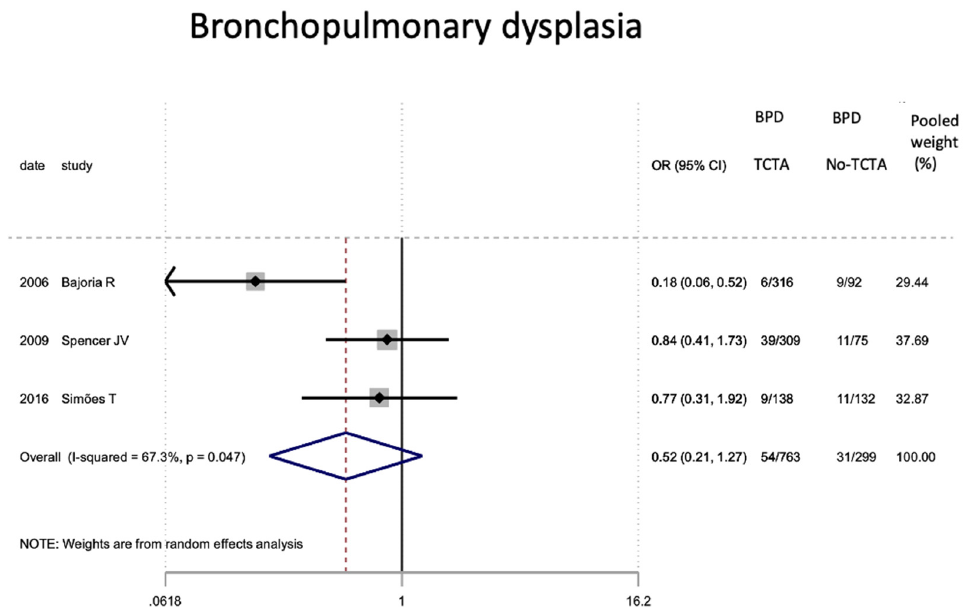
Figure 9. Results of the meta-analysis on the effect of chorionicity (TCTA vs no TCTA) on the development of neonatal bronchopulmonary dysplasia. BPD: bronchopulmonary dysplasia; TCTA: trichorial-triamniotic, non-TCTA: non-trichorial-triamniotic. OR = odds ratio, CI = confidence interval.